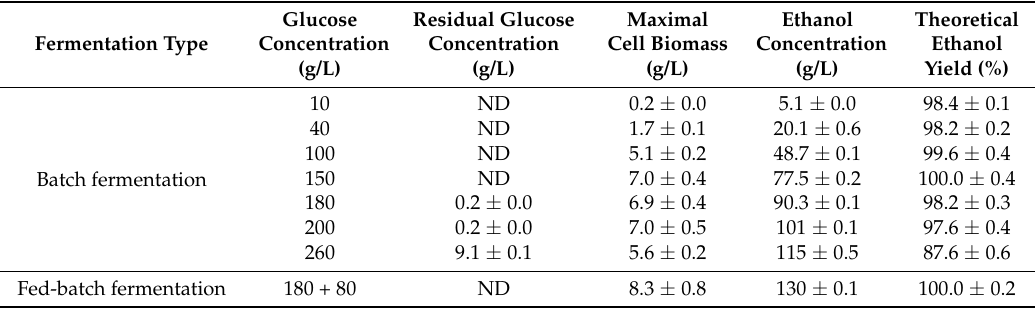
Table 2. Comparison of biomass, sugar, ethanol concentration and theoretical ethanol yield of S. cerevisiae BCRC 21812 by batch and fed-batch